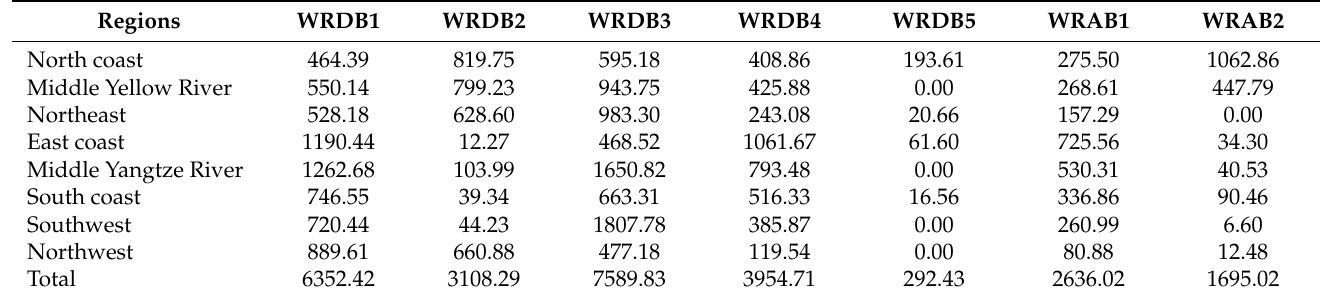
Table 5. CEE of WRDBs and WRABs in eight regions of China in 2020 (10,000